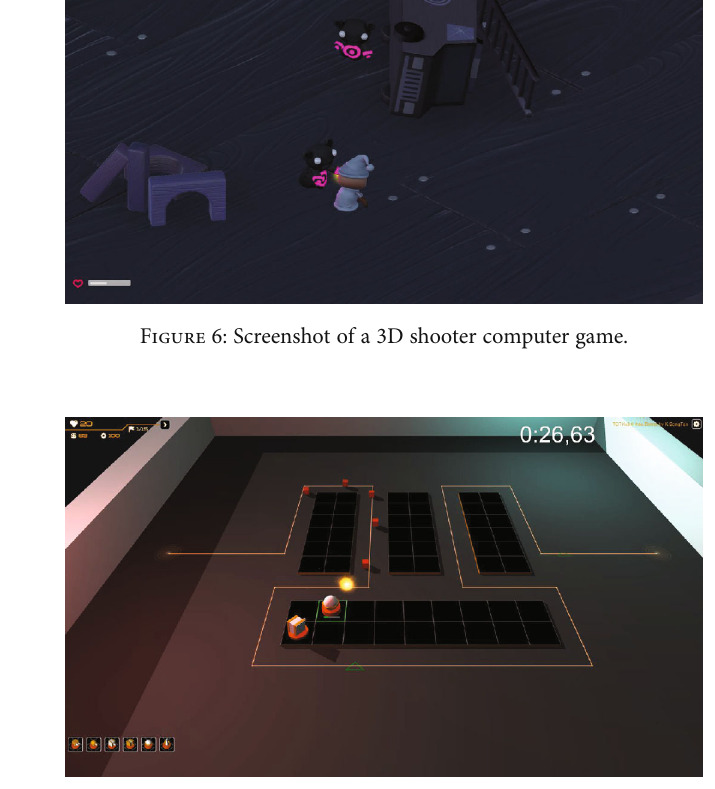
Figure 7: Screenshot of a tower defense computer game.